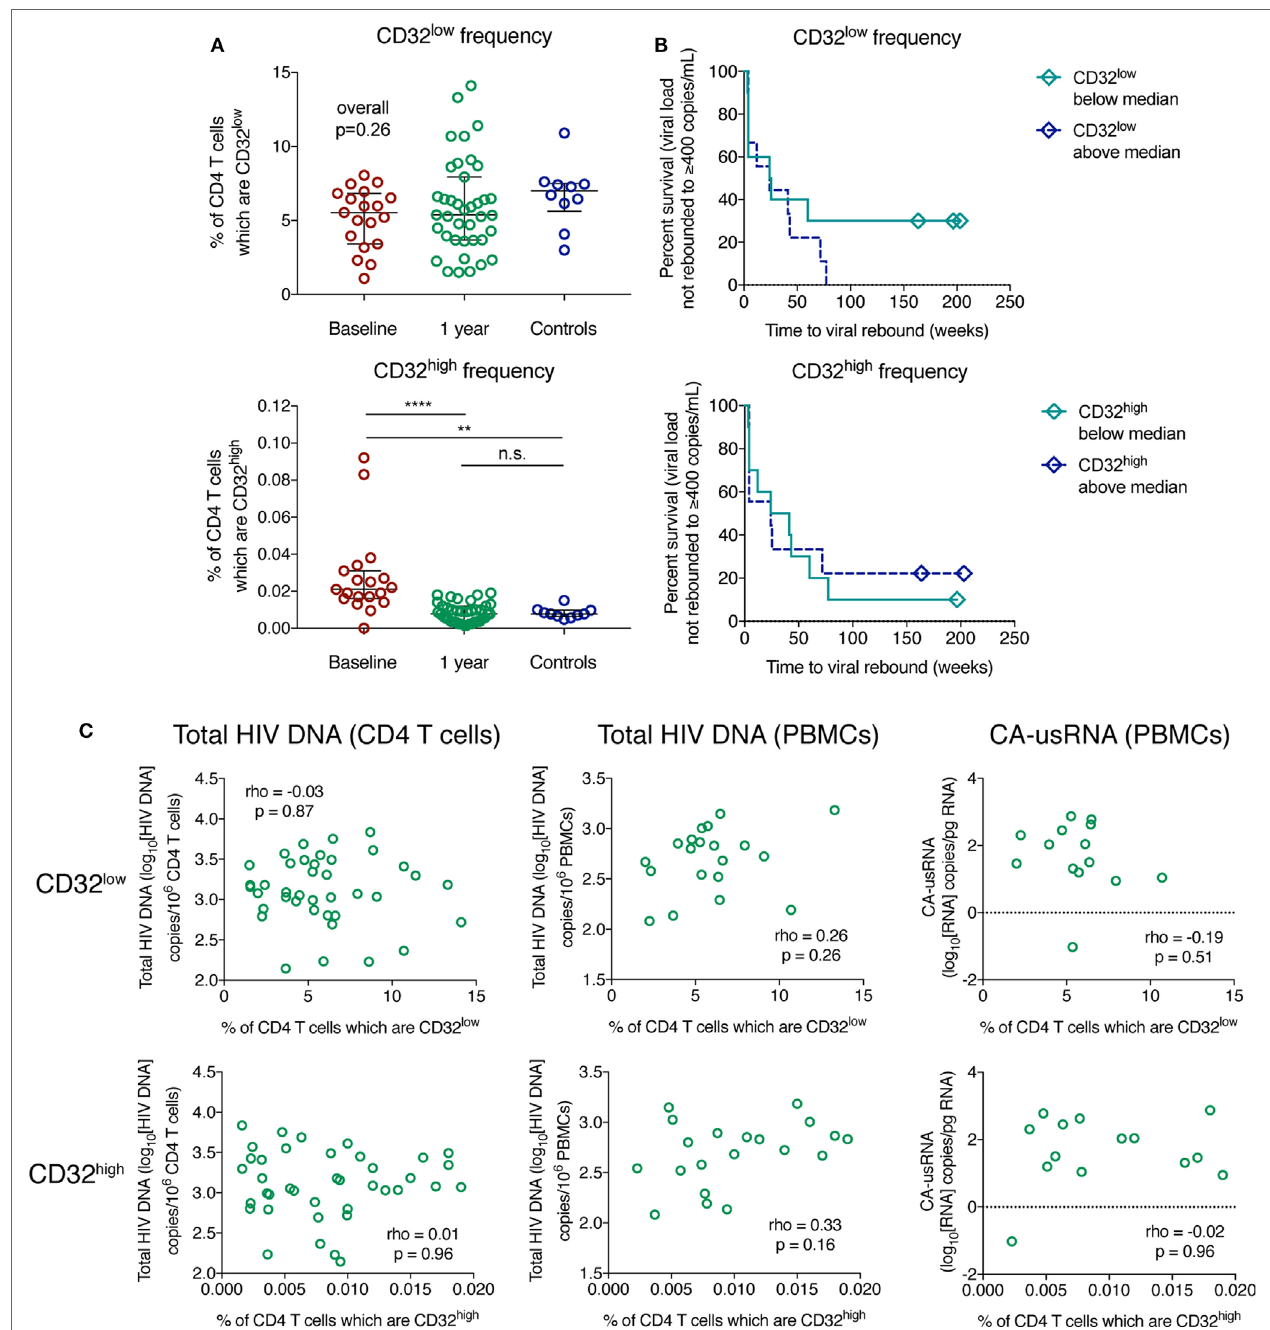
FigUre 5 | The frequency of CD32-expressing CD3 + CD4 + cells does not correlate with the size of the HIV reservoir. The percentage of CD32 low (top panel) and CD32 high (bottom panel) CD3 + CD4 + cell populations is shown in panel (a) for HIV + individuals with primary HIV infection pre-therapy (baseline; n = 19) and 1 year following antiretroviral therapy initiation ( n = 39), as well as for controls ( n = 10); groups were compared using a Kruskal–Wallis test. Bars indicate the median with the interquartile range. Panel (B) shows survival curves (Kaplan–Meier) of time to viral rebound > 400 copies/mL based on the frequency of CD32 low (top panel) and CD32 high (bottom panel) CD3 + CD4 + cells stratified at the median ( n = 19). The relationship between measures of the HIV reservoir and percentage of CD32 low (top panels) and CD32 high (bottom panels) CD3 + CD4 + cells in treated HIV + individuals, shown in panel (c) , was assessed using Spearman’s rank correlation. Left column shows total HIV DNA measured in isolated CD4 T cells ( n = 39), the center column is total HIV DNA measured in peripheral blood mononuclear cells (PBMCs) ( n = 20), and the right column shows cell-associated unspliced HIV RNA ( n = 14); **** p < 0.0001, ** p = 0.001–0.01, n.s. (not significant) indicates p ≥